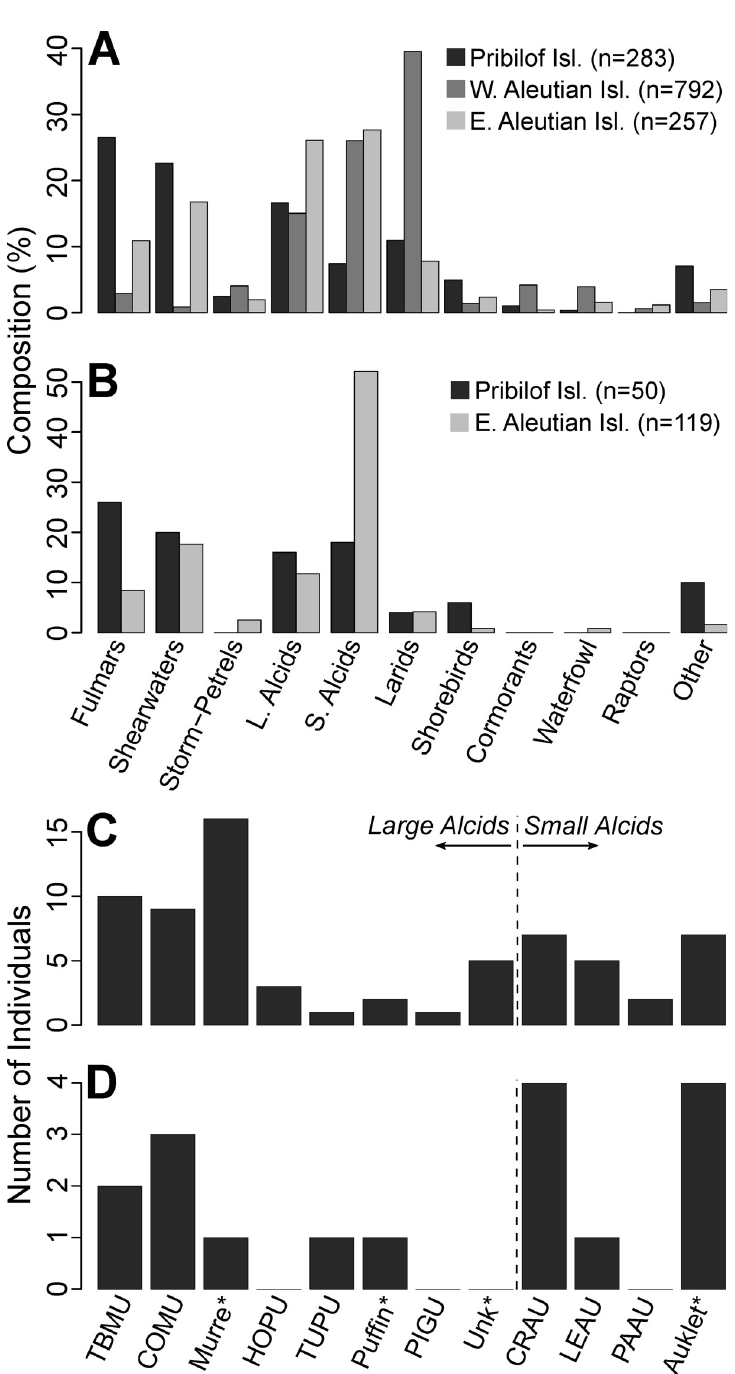
Fig 4. Baseline taxonomic composition of beached bird carcasses found on the Pribilof Islands and Aleutian Islands. Species composition is shown year round (A) and for the fall/winter period (B—September to December) for all taxonomic groups recorded on the Pribilof Islands, Alaska and the eastern and western Aleutian Islands, Alaska. Fall/winter data were unavailable from the Western Aleutian Islands. Alcid species composition is shown for the Pribilof Islands year round (C) and for the fall/winter period (D). Asterisks ( � ): carcasses identified to group but not species. TBMU: Thick-billed murre ( Uria lomvia ), COMU: Common murre ( Uria aalge ), HOPU: Horned puffin, TUPU: Tufted puffin, PIGU: Pigeon guillemot ( Cepphus columba ), CRAU: Crested auklet, LEAU: Least auklet, PAAU: Parakeet auklet ( Aethia psittacula ).